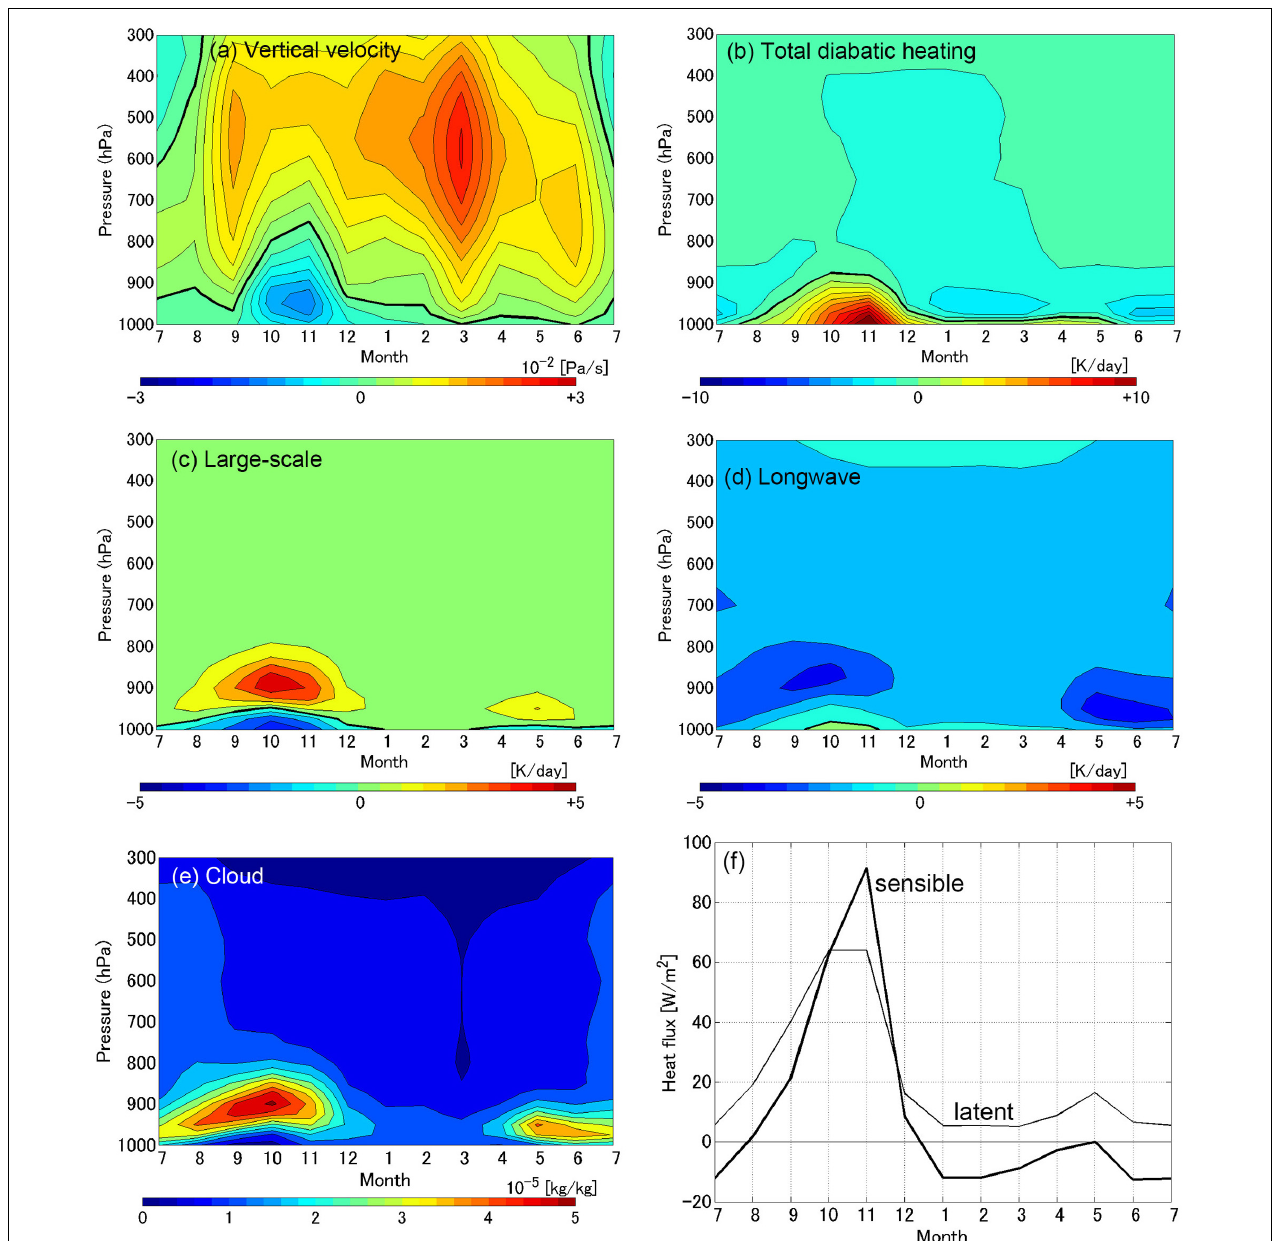
FIGURE 5 | Seasonal variations of (a) vertical velocity, (b) total diabatic heating rate, (c) large-scale condensation component, (d) longwave radiation component, (e) cloud water mixing ratio, and (f) surface turbulent heat fluxes averaged over the area of 68.0–72.5 ◦ N, 167.5–174.0 ◦ W (black solid box in Figure 2 ) in the Chukchi Sea. Negative values in (a) indicate ascending motion. Black bold lines in (a–d) are zero